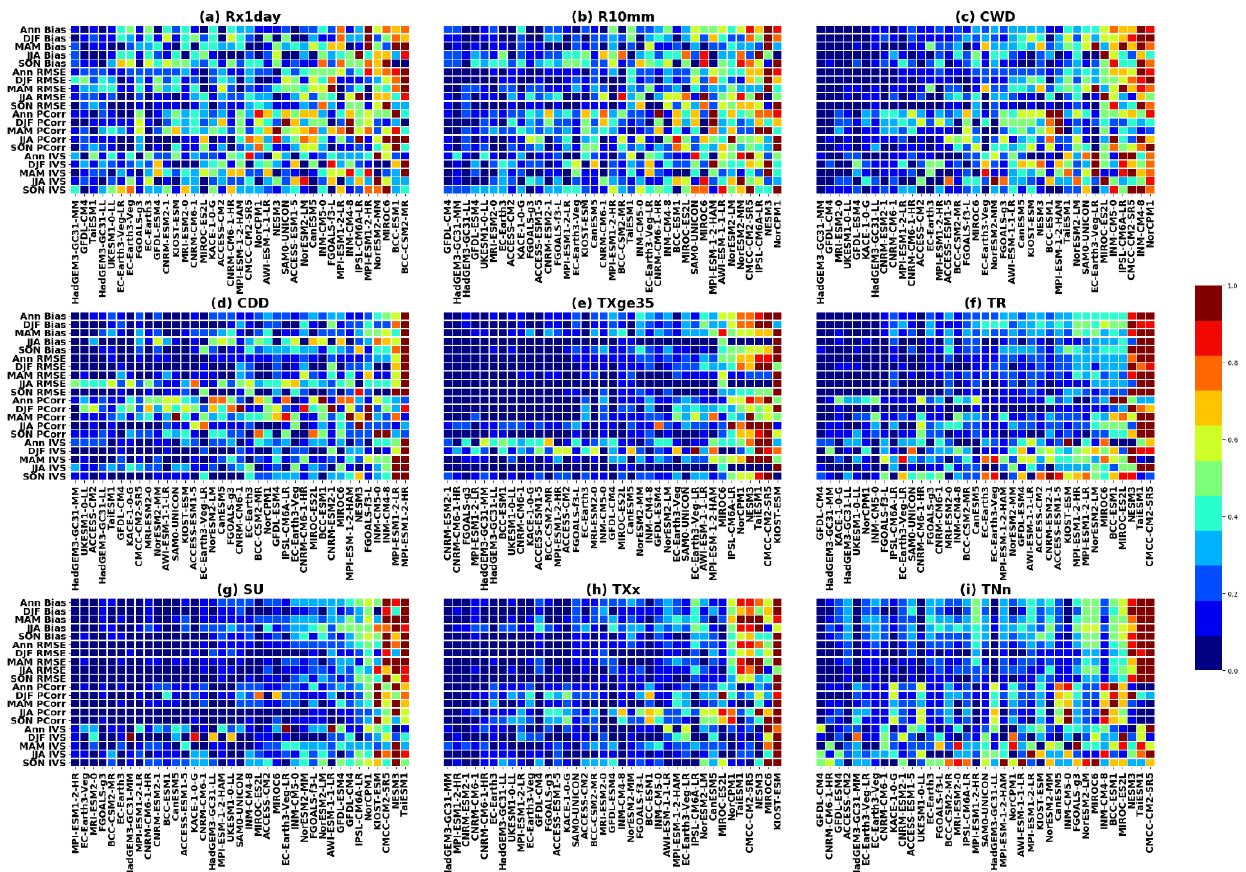
Figure 13. Normalised and continentally averaged annual and seasonal means of individual metrics (bias, root mean square error (RMSE), pattern correlation (PCorr) and interannual variability score (IVS)) for the extreme indices ( a ) maximum 1-day precipitation (Rx1Day), ( b ) number of very heavy rain days (rain > 10 mm) (R10mm), ( c ) consecutive wet days (CWD), ( d ) consecutive dry days (CDD), ( e ) number of days when maximum temperature is greater than 35 °C (Txge35), ( f ) tropical nights (number of days when minimum temperature > 20 °C) (TR), ( g ) summer days (number of days when maximum temperature > 25 °C) (SU), ( h ) maximum maximum-temperature (TXx) and ( i ) minimum minimum-temperature (TNn). Here, the smaller values of normalised metrics correspond to the better performance of GCMs. Moreover, for each extreme index, GCMs are arranged from best to worst performance as we move from left and right. Data spans 1951–2014.